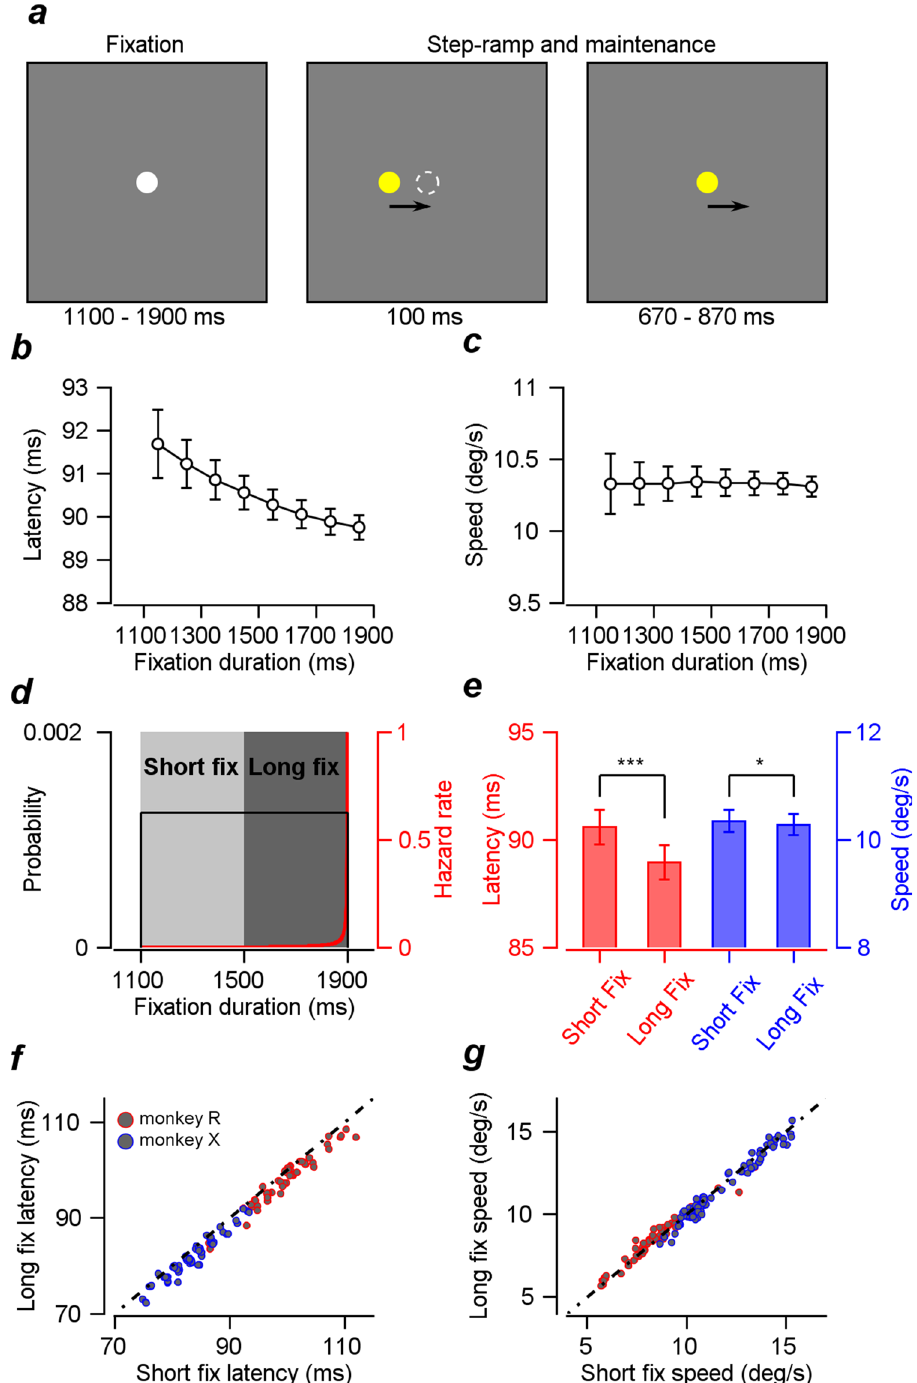
Figure 1. Experimental design and the effect of temporal expectation on smooth pursuit behaviors. ( a ) Temporal structure of the step-ramp smooth pursuit task. ( b ) The average pursuit latency as a function of the fixation duration. As the fixation duration increases, the latency decreases. Error bars are standard errors. ( c ) The average pursuit speed as a function of the fixation duration. The fixation duration did not modulate the pursuit speed. Error bars are standard errors. ( d ) The probability distribution of fixation duration and hazard rate. Light and dark gray shaded areas denote the two fixation duration conditions. ( e ) Average latency and speed differences in the two groups sorted by fixation duration. Both latency and speed differences were significant; however, the latency difference was more pronounced. Error bars are standard errors. ( f ) Scatter plot of mean pursuit latencies in short and long fixation duration conditions. The dotted line is the unity line. ( g ) Scatter plot of mean pursuit speeds in short fixation duration vs. those in long fixation duration